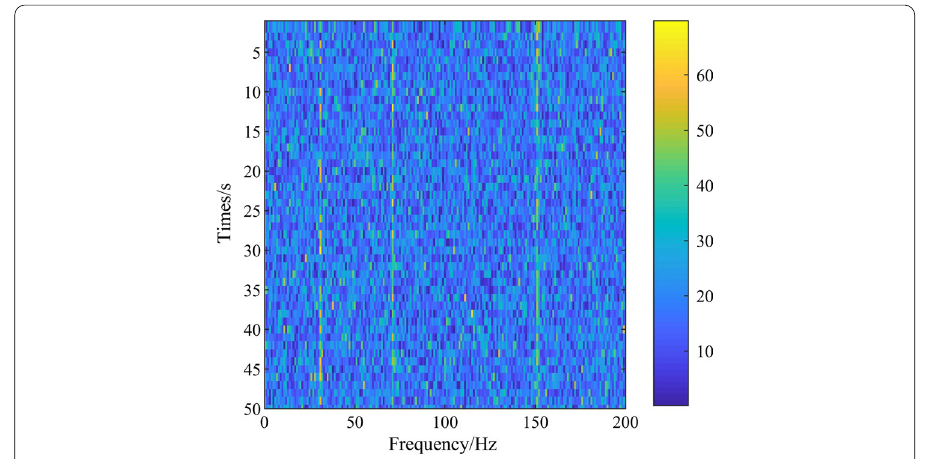
Fig. 5 Original lofargram at signal-to-noise ratio of